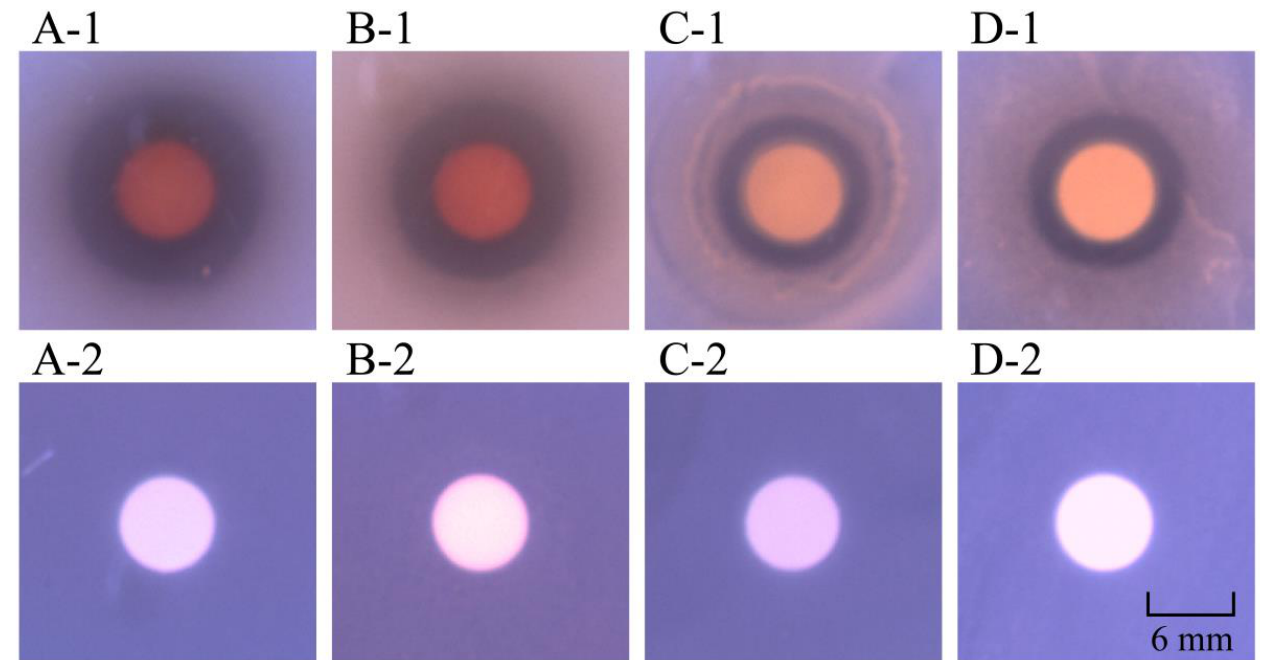
Figure 1. Inhibition activity of the methanol-phase crude extract from P. kleiniana Wight et Arn against the four representative bacterial strains. ( A-1 – D-1 ) V. parahemolyticus B5-29, V. parahemolyticus ATCC17802, S. aureus ATCC25923, and S. aureus ATCC8095, respectively. ( A-2 – D-2 ) corresponding negative controls, respectively.